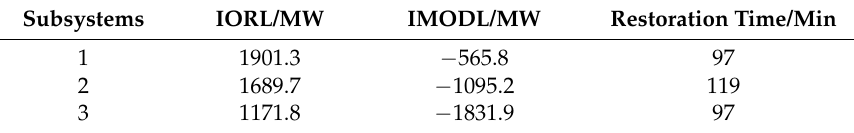
Table 2. The sectionalizing result of IEEE 39-bus test system.